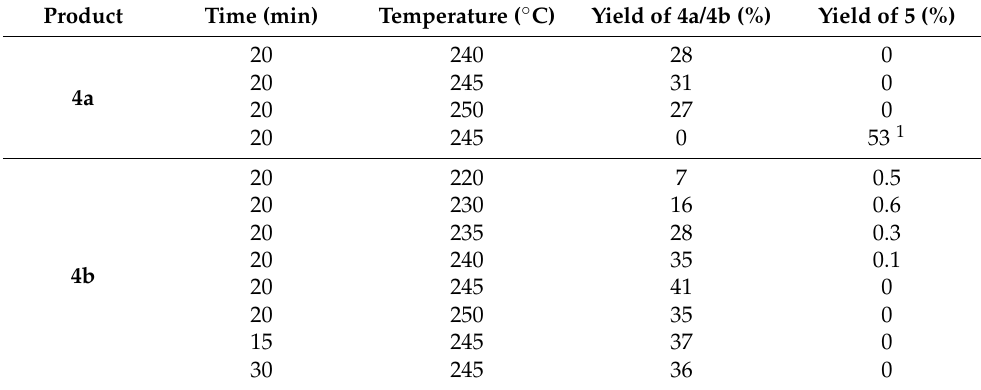
Table 1. Reaction conditions ( i ) for the synthesis of 4a,b and 5